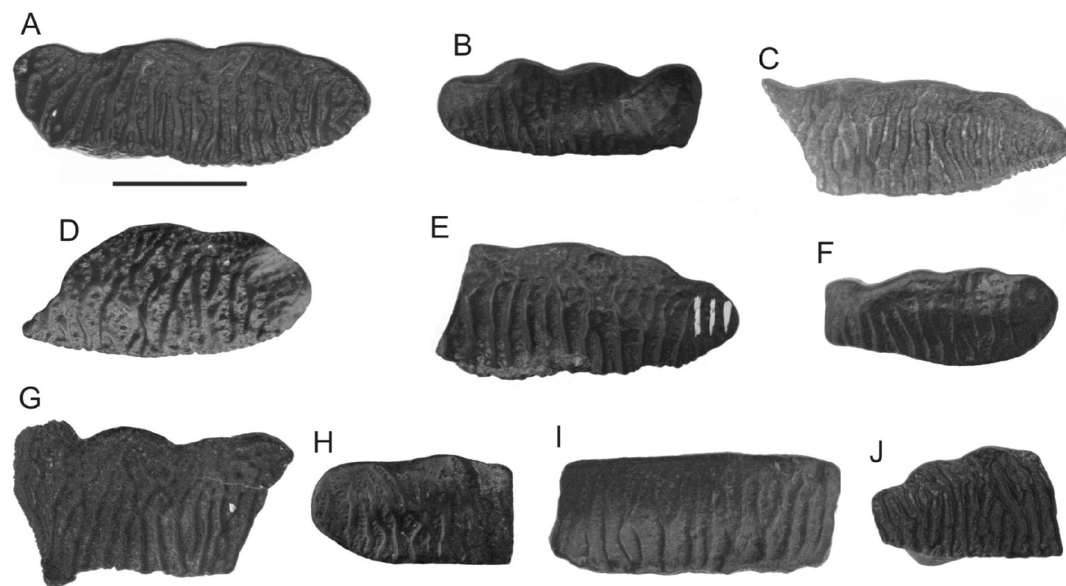
Fig. 3 – Equinoxiodus alcantarensis : A) Holotype, UFMA 1.40.086, B) UFMA 1.40.060, C) UFMA 1.40.079, D) UFMA 1.40.489, E) UFMA